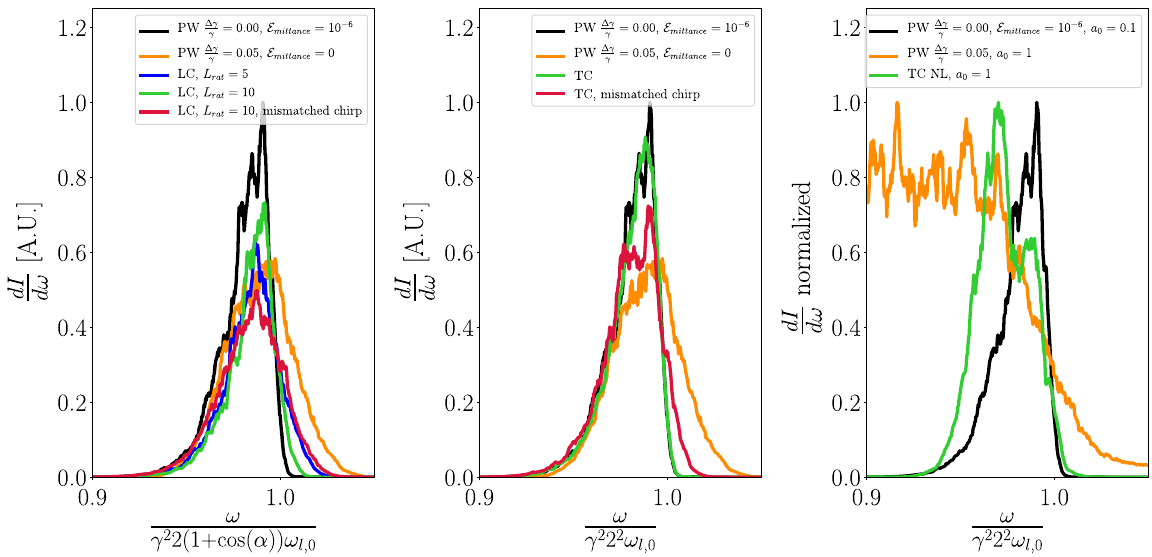
¼ 1 FIG. 6. Calculated spectra within ϑ for a circularly polarized laser pulse with parameters ω l; 0 ¼ 1 . 77 × 10 15 [ 1 ], N c ¼ 150 , 10 γ s max ¼ 30 × 10 − 4 ½ cm (cid:2) , and electron parameters γ ¼ 10 3 , σ ¼ 15 × 10 − 4 ½ cm (cid:2) and σ ¼ 15 . 75 × 10 − 4 ½ cm (cid:2) . Further specific W 0 x;y z ¼ 0 . 00 and E ¼ 1 ½ mm mrad (cid:2) parameters are given below. For the PW case two simulations were performed: one with Δ γ γ mittance ¼ 0 . 05 and E ¼ 0 ½ mm mrad (cid:2) . Left: LC with collision angle α ¼ 52 . 8 deg and a ¼ 0 . 1 . The frequency and one with Δ γ 0 γ mittance ¼ 0 . 14 . The energy spread for the electron bunch for blue and green is Δ γ ¼ 0 . 05 and bandwidth for cases in blue, green and red is Δ ω B ω l; 0 γ ¼ 0 . 07 . The peak frequency is lower due to the collision angle. Middle: TC with a ¼ 0 . 1 . For the frequency bandwidth for for red Δ γ 0 γ ¼ 0 . 14 . The energy spread for the electron bunch for green is Δ γ ¼ 0 . 05 and for red Δ γ ¼ 0 . 07 . Right: TC cases in green and red is Δ ω B ω l; 0 γ γ NL with a 0 ¼ 1 . The vertical axis is normalized to 1. This is done because the unchirped laser pulse case has very little radiation in this region, and to compare it to the LT PW case which has a different